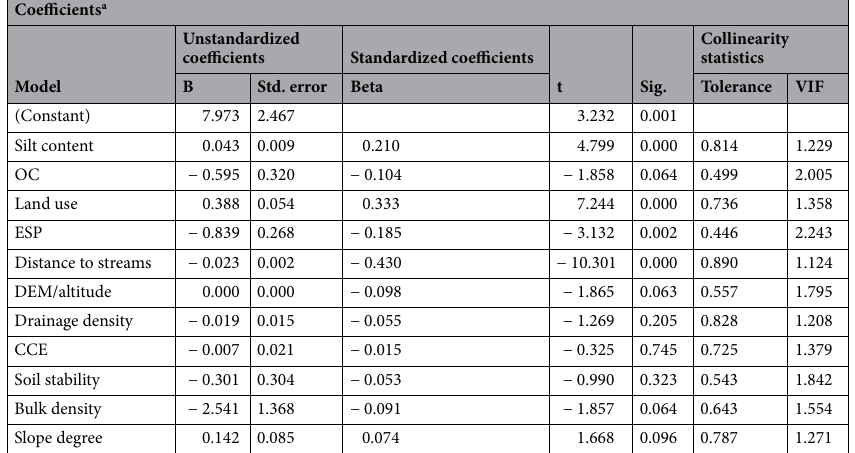
Table 1. Multicollinearity analysis for Collapsed pipes in 2021. CCE, calcium carbonate equivalent; OC, organic carbon; ESP, exchangeable sodium percentage. a Dependent variable: collapsed pipes